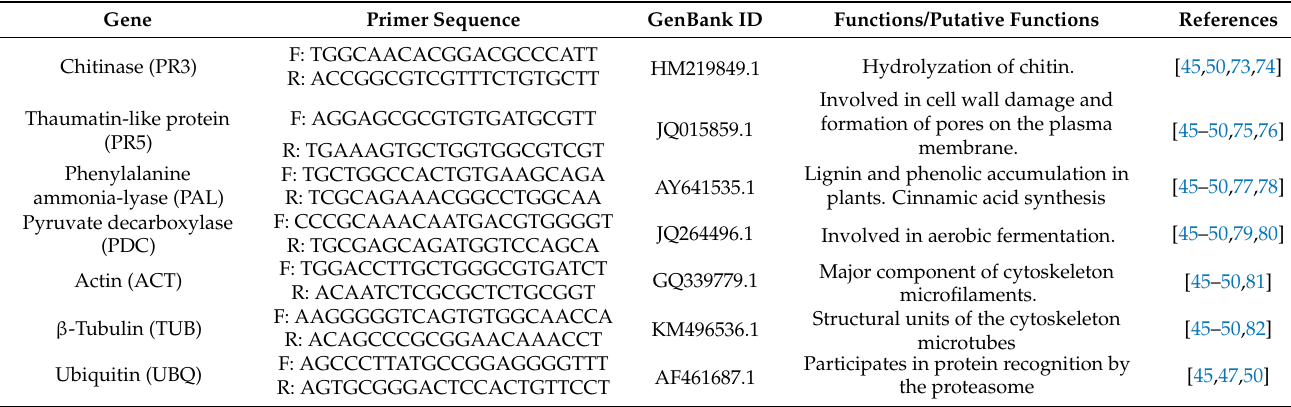
Table 1. Primer sequences used for the amplification of housekeeping and candidate genes studied in the multi-factorial system Pinus radiata - Fusarium circinatum - Phytophthora species. Gene Primer Sequence GenBank ID Functions/Putative